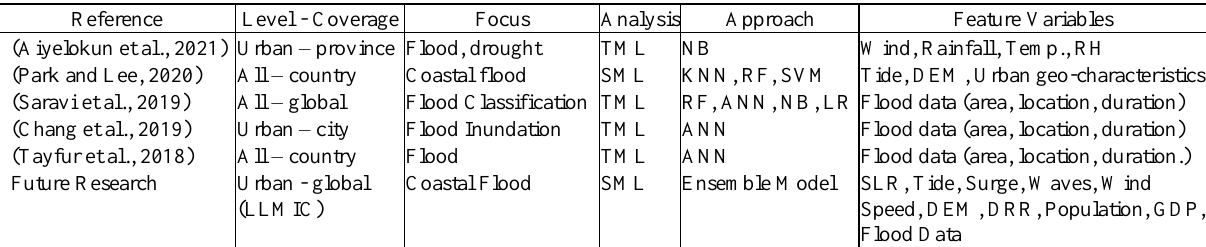
Table 1 . Review on coastal flood risk simulation through ML 3.2 Distribution of Urban Settlement across LLMIC